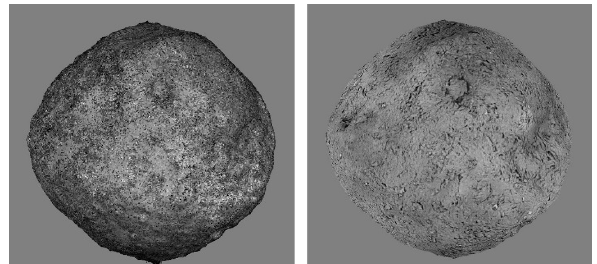
Figure 7. Dense point cloud and textured 3D model